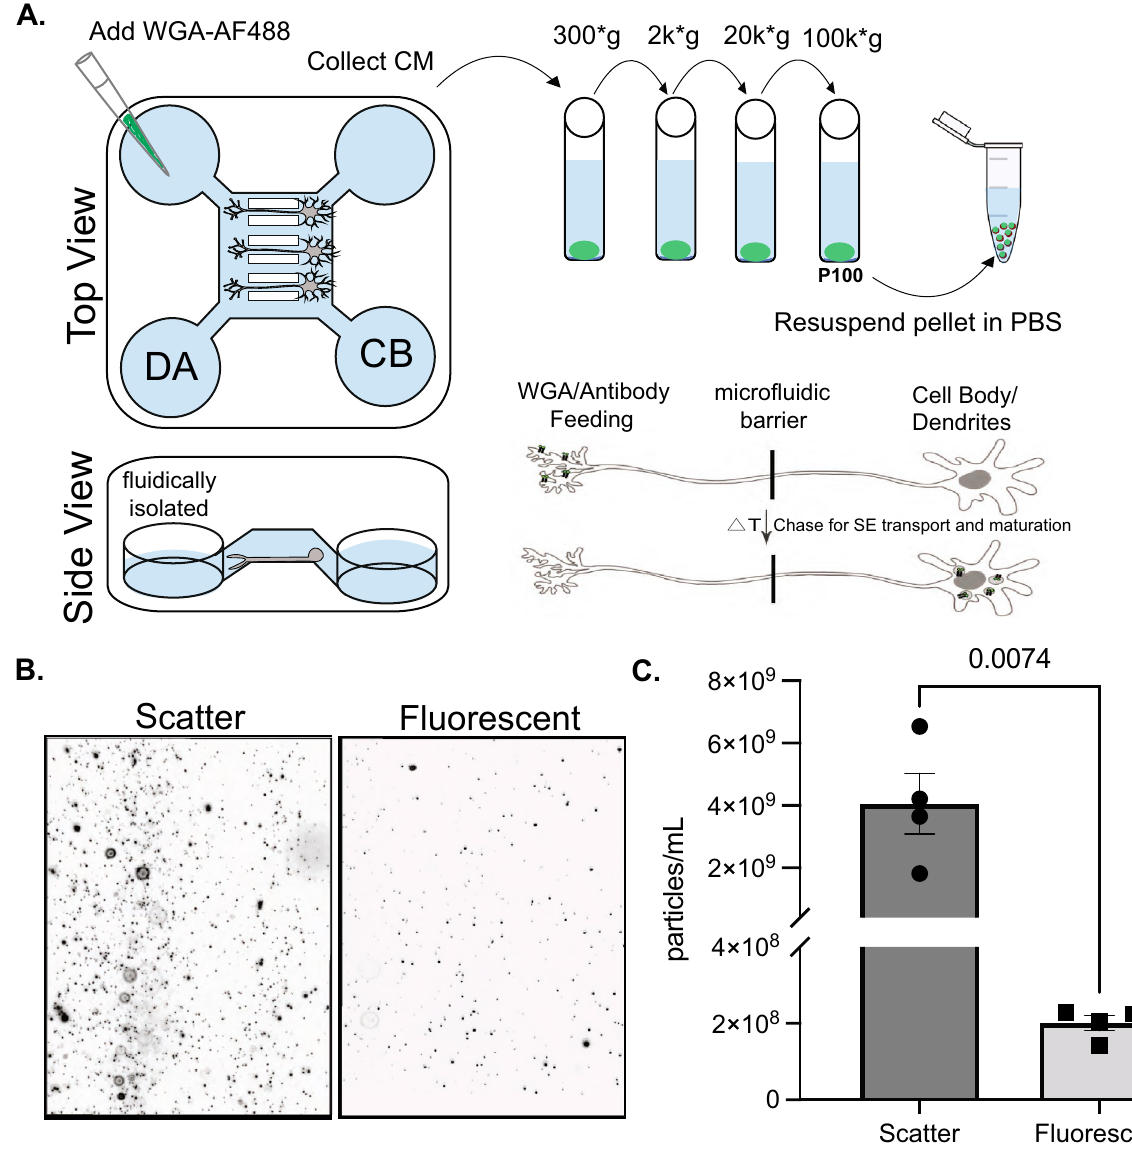
Figure 3. Somatodendritcally secreted sympathetic EVs carry cargo originating in the distal axon. ( A ) Schematic of the WGA-AF488 feeding assay in MFDs. WGA-AF488 was added to the distal axon (DA) chamber which was fluidically isolated from the cell body (CB) chamber. ( B ) Still frames captured from NTA videos at t = 30 secs in scatter and fluorescent mode. ( C ) Quantification of the total number of particles (scatter) and the number of fluorescent (WGA-AF488 + ) particles collected from the P100 fraction after WGA-AF488 addition to the DA chamber of MFDs containing wild-type SCG neurons. Shown is the mean ± SEM for four biological replicates. P values are indicated above the pairwise